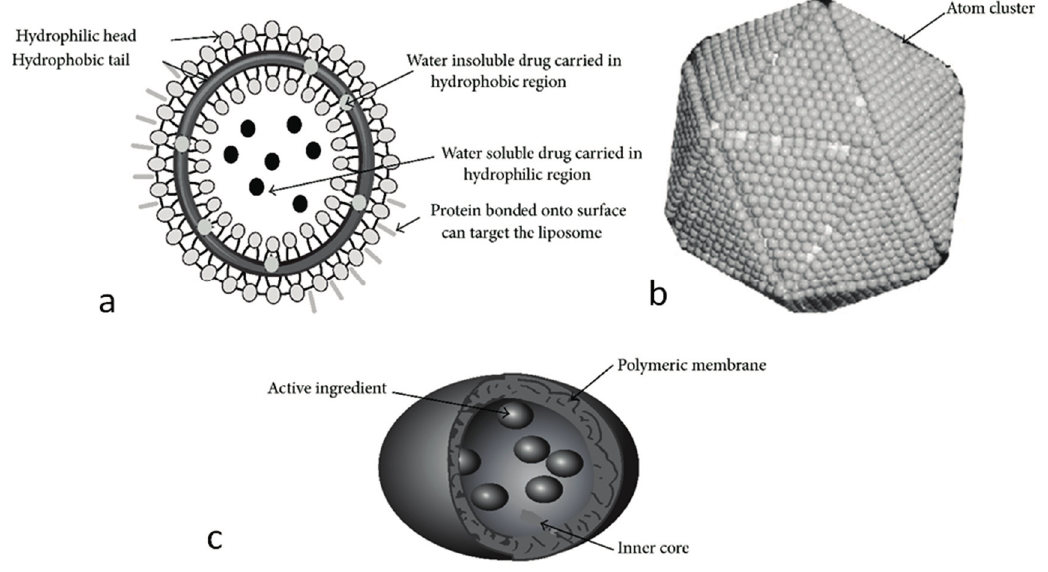
Figure 1. Examples of different types of nanoparticles. ( a ) Liposome showing a phospholipid bilayer surrounding an aqueous interior; ( b ) solid lipid nanoparticle; ( c ) nanocapsule loaded with an active ingredient